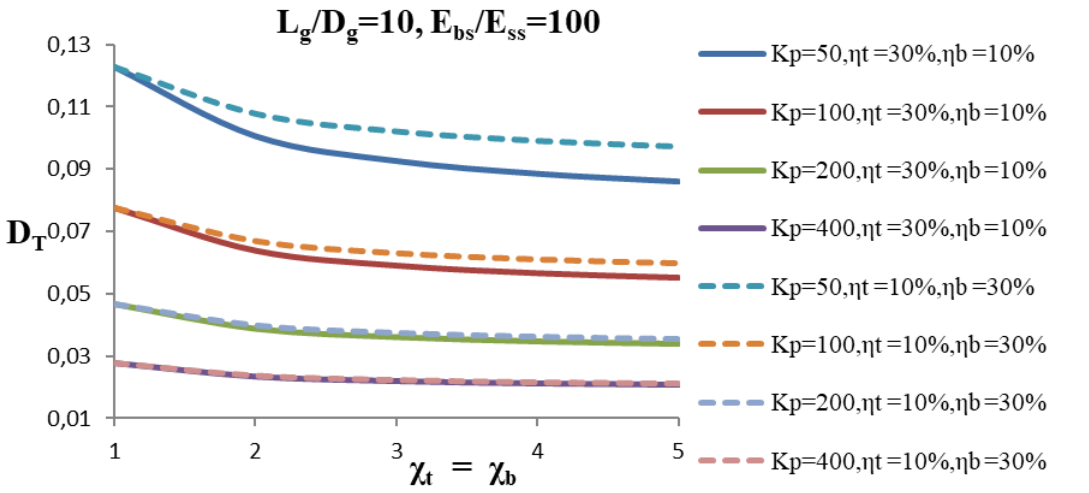
, with strengthening factor for the top, χ T ; PLST of GP, η p